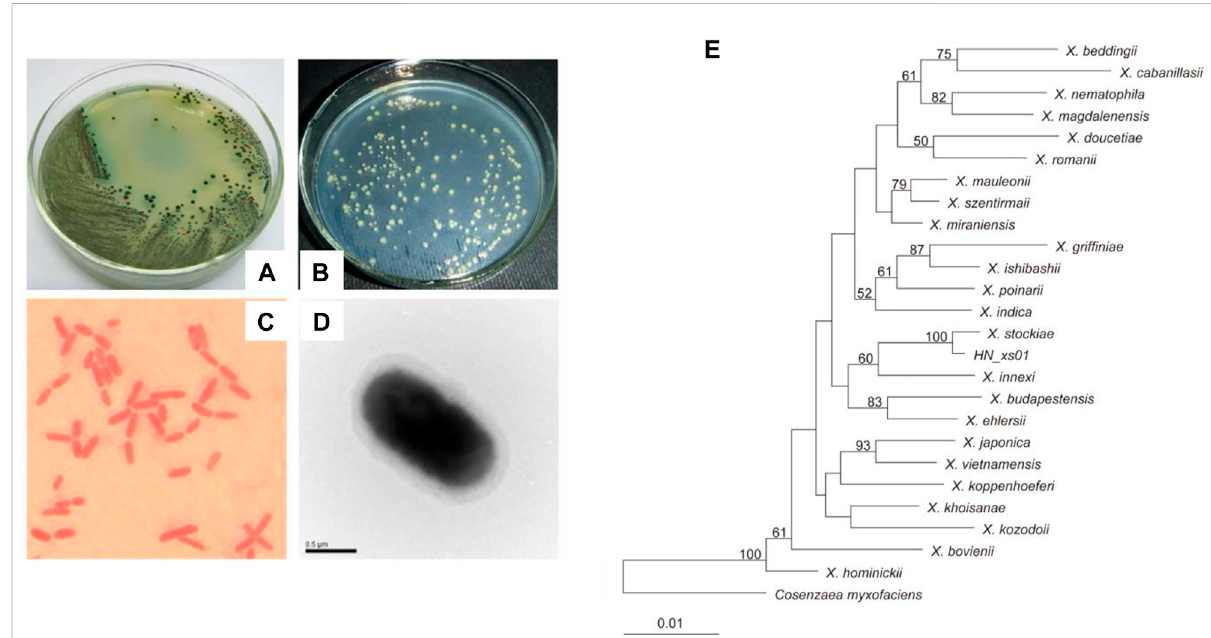
FIGURE 1 Morphology and phylogenetic analysis of strain HN_xs01. (A) Colony morphology of HN_xs01 on NBTA plate. (B) Colony morphology of HN_xs01 on LB plate. (C) Sarranine staining of HN_xs01. (D) The transmission electron microscopy of HN_xs01. (E) Phylogenetic dendrogram of HN_xs01. Bootstrap values are based on 1,000 replicates. The dendrogram was obtained by distance matrix analysis of 16S rRNA gene